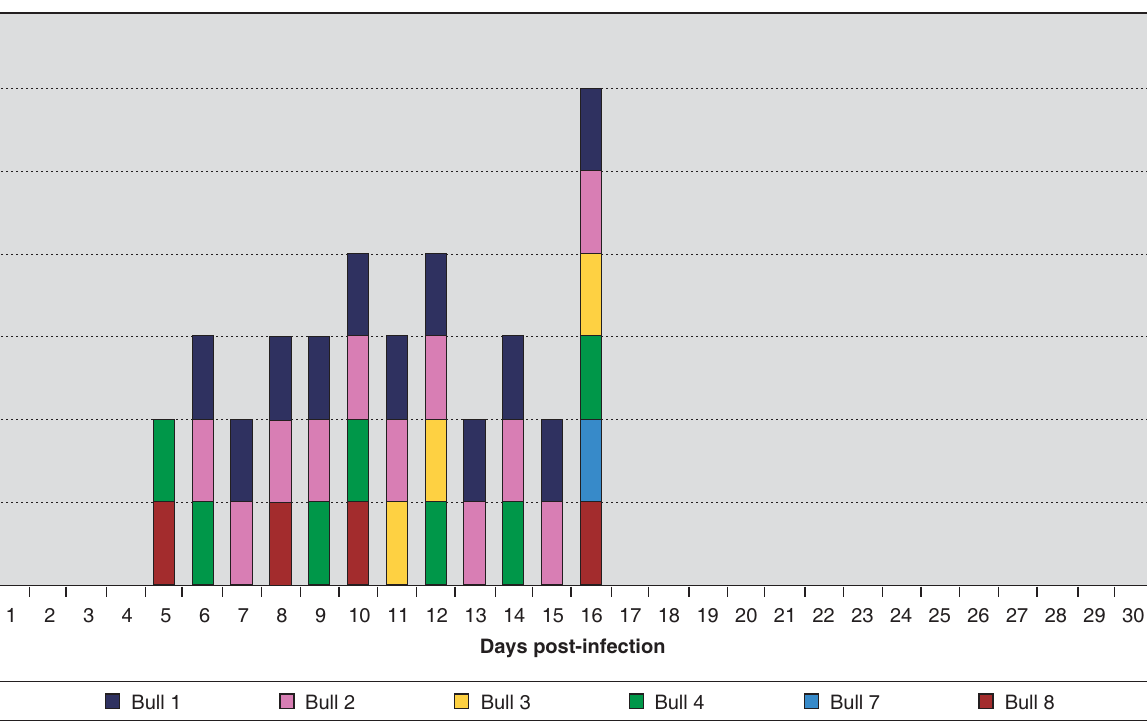
FIG. 3 PCR results from EDTA blood